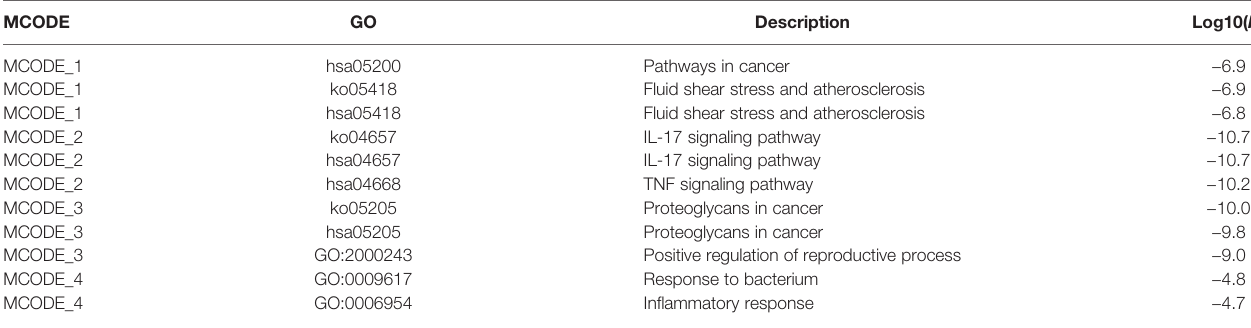
TABLE 3 | MCODE enrichment analysis of TF – targets in rosacea and